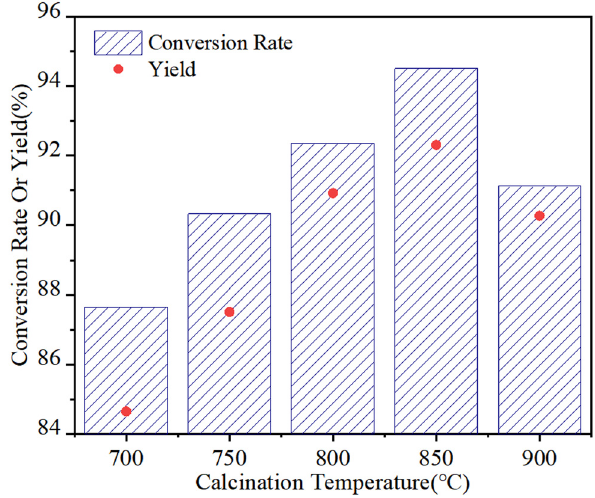
Figure 6: E ff ect of the calcination temperature on the catalytic per - formance of Fe – Sn – O.